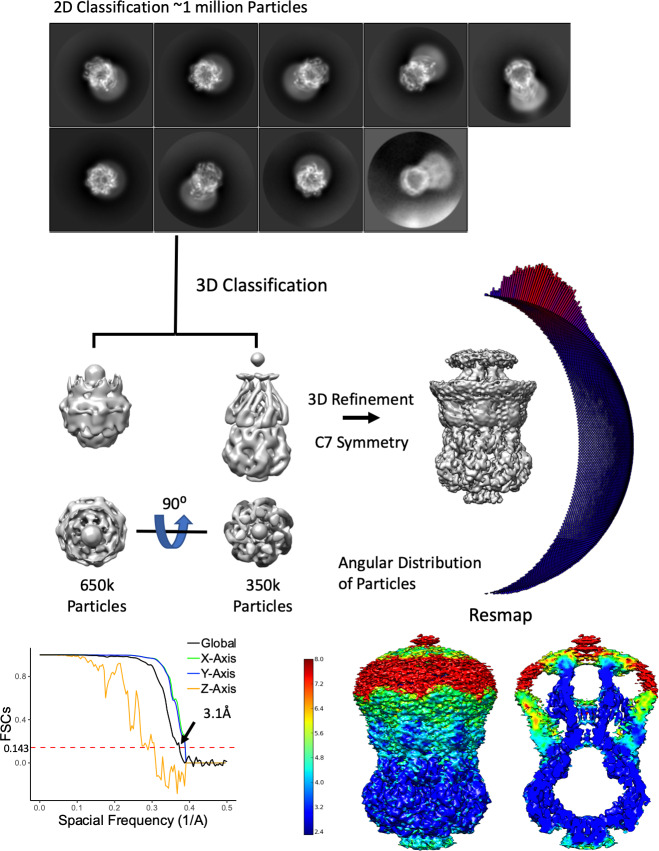
Overview of MscS ND Density Refinement Workflow.From 4403 movies, about 1 million particles were picked and 2D classified. The selected 2D classes were subjected to multiple rounds of 3D classification were truncated (possibly denatured due to the air-water interface) particles were classified out. The final reconstruction used only the 3D classes with the entire molecule. As can been seen in the 2D classes, the angular distribution of particles and the 3D FSC (Tan et al., 2017) there is an orientation preference of the top views, which in turn cause anisotropy in the Z direction. Finally, the Resmap map shows the structure is 3 Å or better except for the anchor domain and the TM1/2 hairpin.